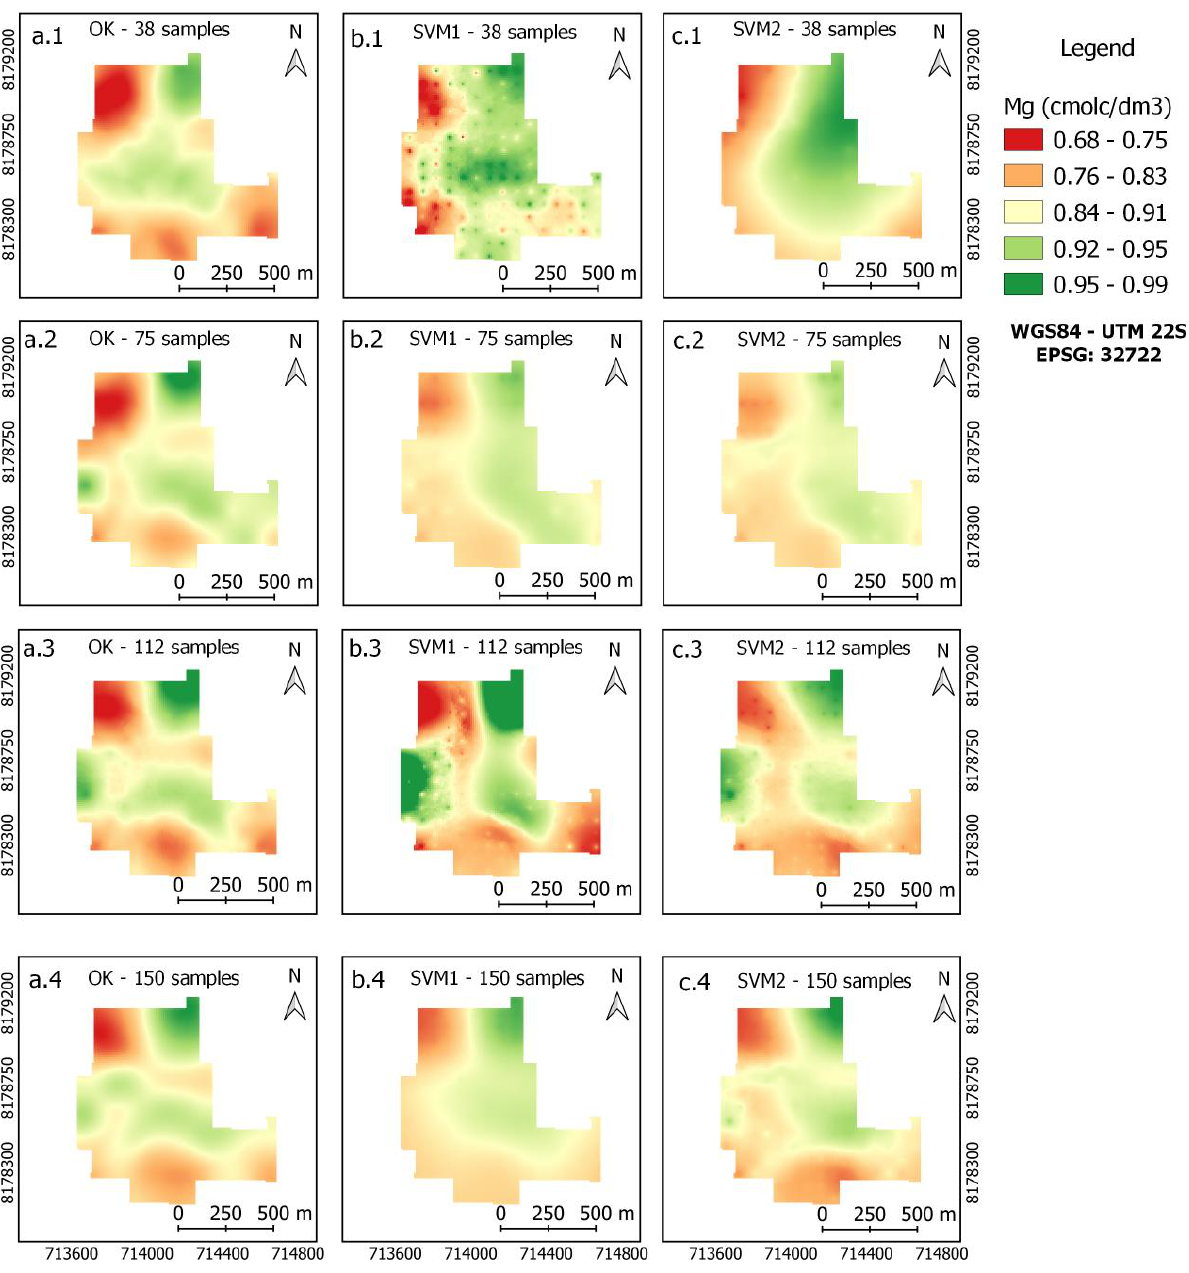
Figure 12. Maps obtained by interpolation of Magnesium (Mg 2+ ): ( a ) OK, ( b ) SVM1 , ( c ) SVM2 ; Set of points (training): 38 ( a.1 – c.1 ), 75 ( a.2 – c.2 ), 112 points ( a.3 – c.3 ), and 150 points ( a.4 – c.4 ).